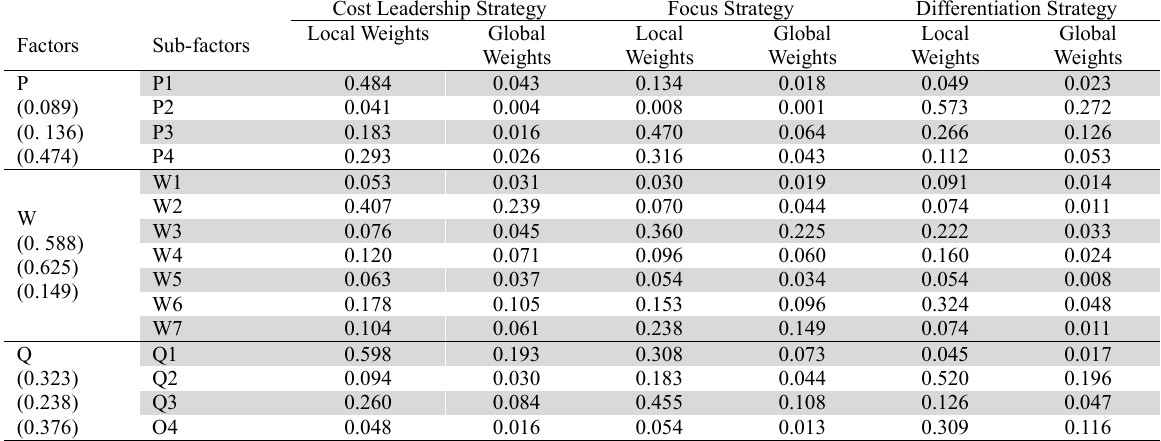
Computed local and global weights for factors and sub-factors for each